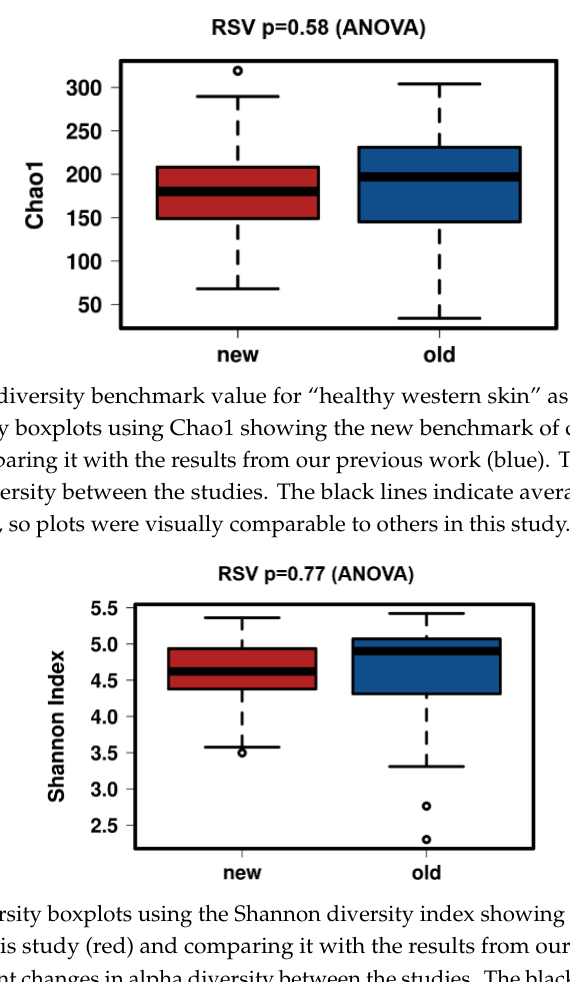
Figure 2. Alpha diversity boxplots using the Shannon diversity index showing the new benchmark of diversity found in this study (red) and comparing it with the results from our previous work (blue). There are no significant changes in alpha diversity between the studies. The black lines indicate average diversity. Samples were rarefied to 6600 sequence reads.